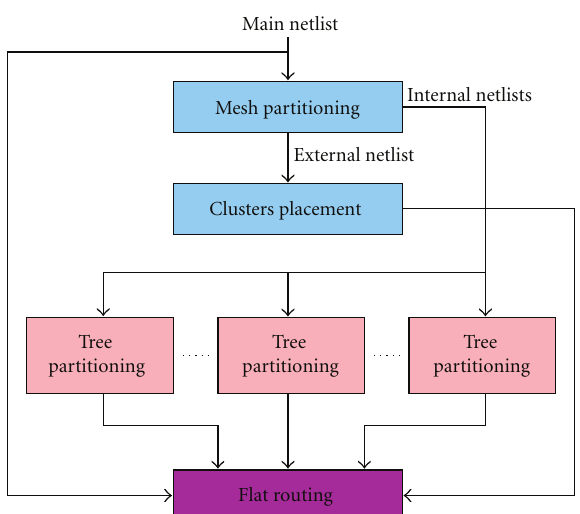
Figure 21: Mesh of Tree configuration